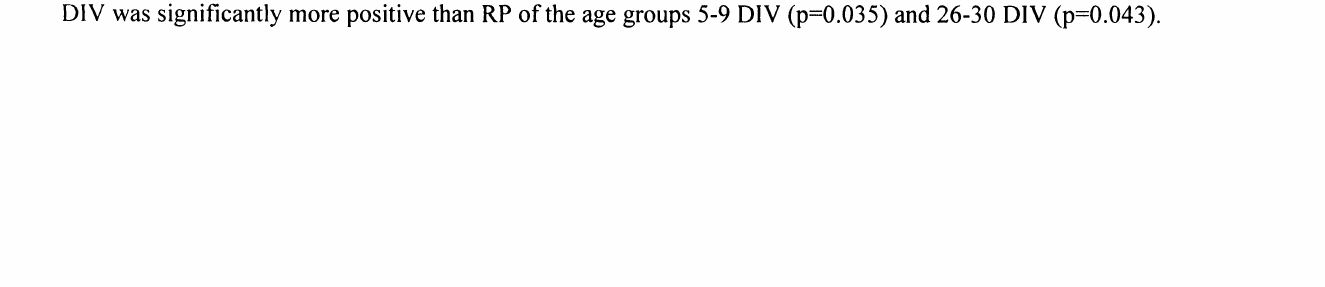
RP, resting membrane potential; x, membrane time constant; RN, input resistance; S-Th, spike threshold; S-A, spike amplitude; S-D, spike duration (half-width). Values represent mean + standard deviation. *RP ofthe age group 19-23 DIV was significantly more positive than RP of the age groups 5-9 DIV (p=0.035) and 26-30 DIV